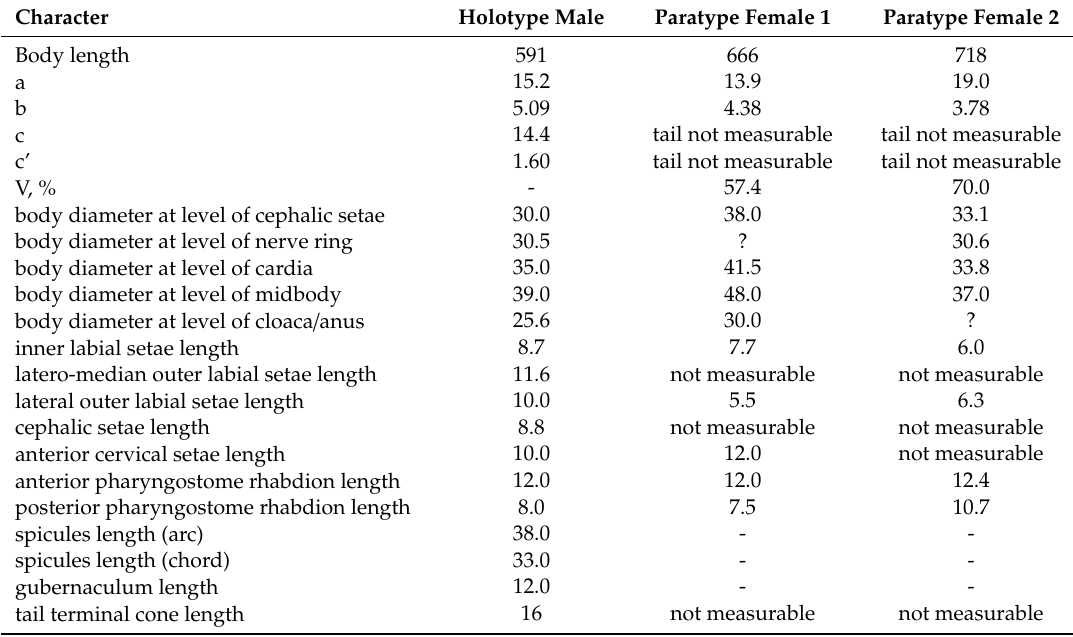
Table 4. Latronema obscuramphis sp. n.,